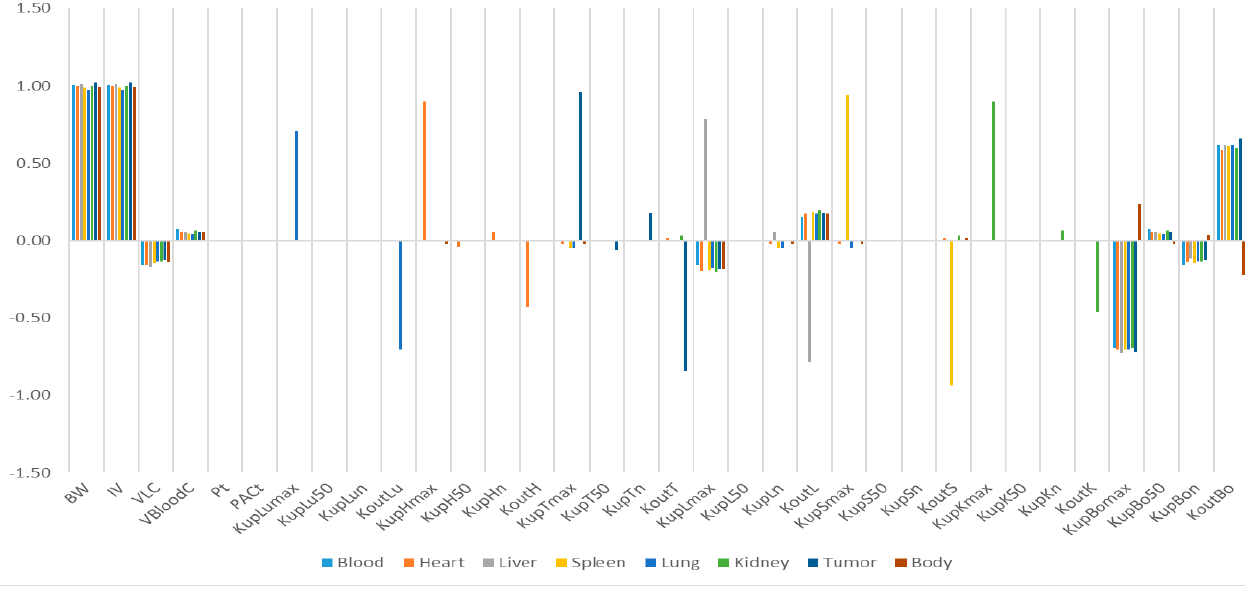
Figure 9. Relative sensitivity analyses for the parameters of mPEG5k-9.09%-200 nm NPs.